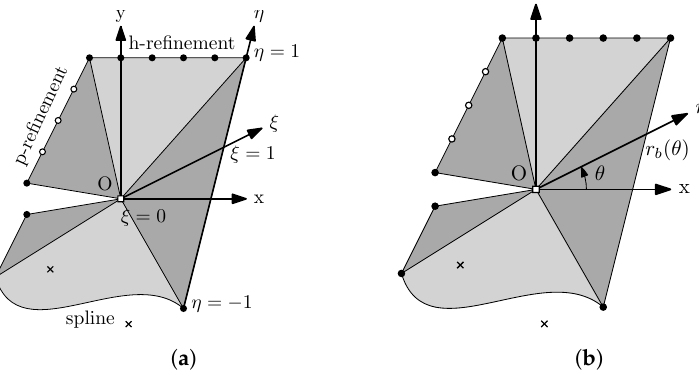
Figure 2. Domain discretisation, scaling center O and introduction of scaled boundary coordinates. ( a ) Polygon domain with scaled boundary coordinates; ( b ) Transformation of singular stress field around crack tip to polar